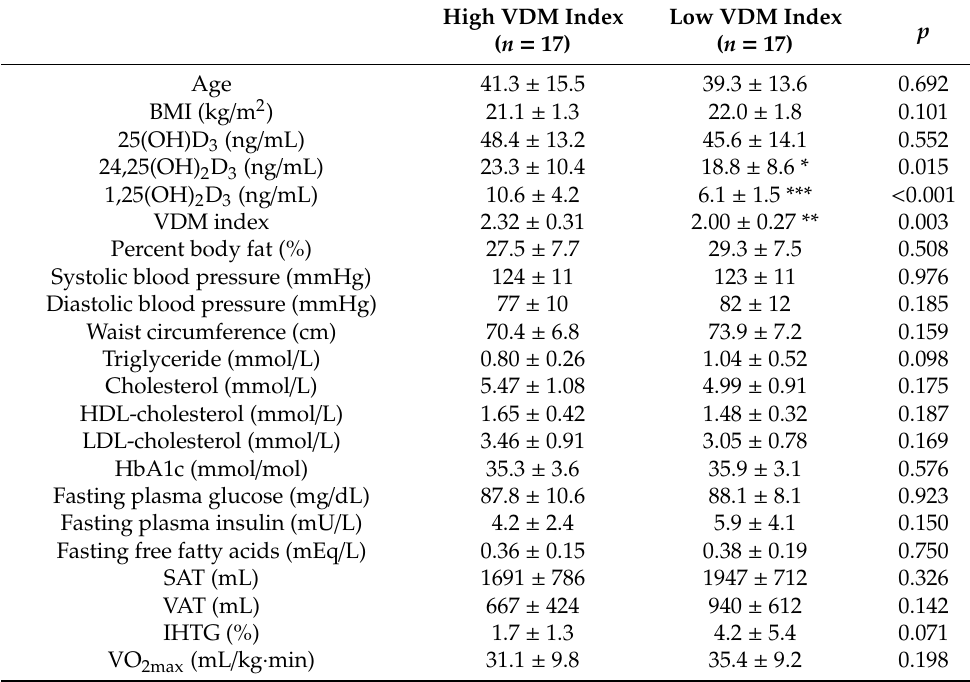
Figure 2. Peripheral insulin sensitivity ( a ) and the static, dynamic, and total ( b – d ) disposition index (DI) in the high and low VDM index subjects matched for age, sex, BMI, and vitamin D exposure